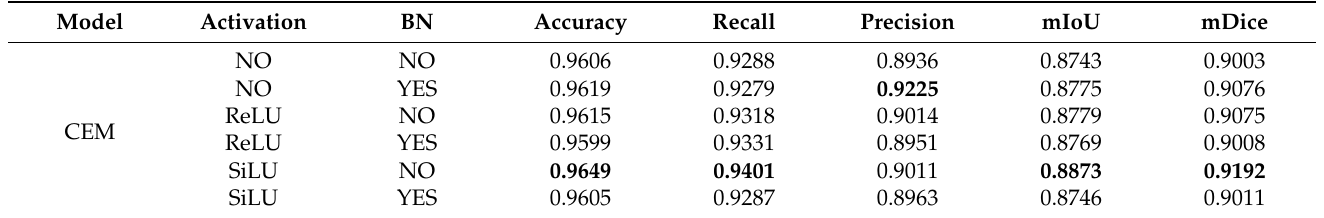
Table 3. Comparison before and after using different activation functions and Batch Normalization